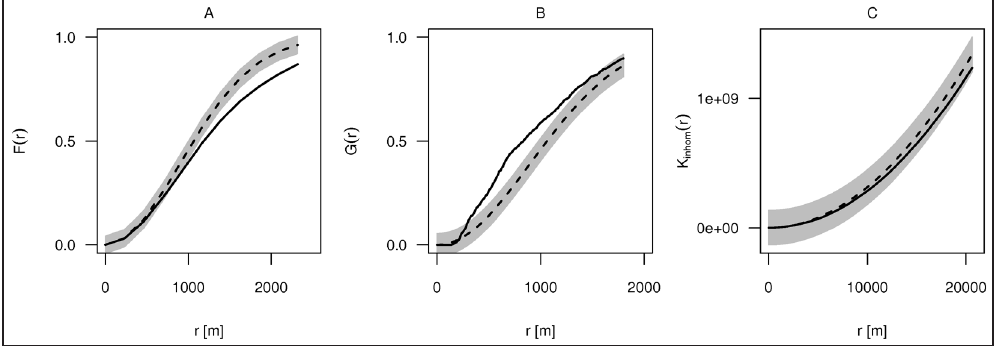
Figure 6: Diggle’s F (A), Diggle’s G (B) and the inhomogeneous K-function (C) (continuous line) with CSR (dashed line) and simultaneous critical envelopes (grey